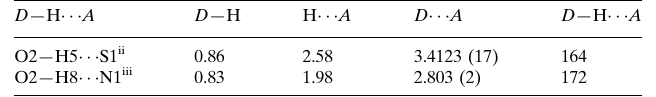
Hydrogen-bond geometry (A˚ , (cid:1)